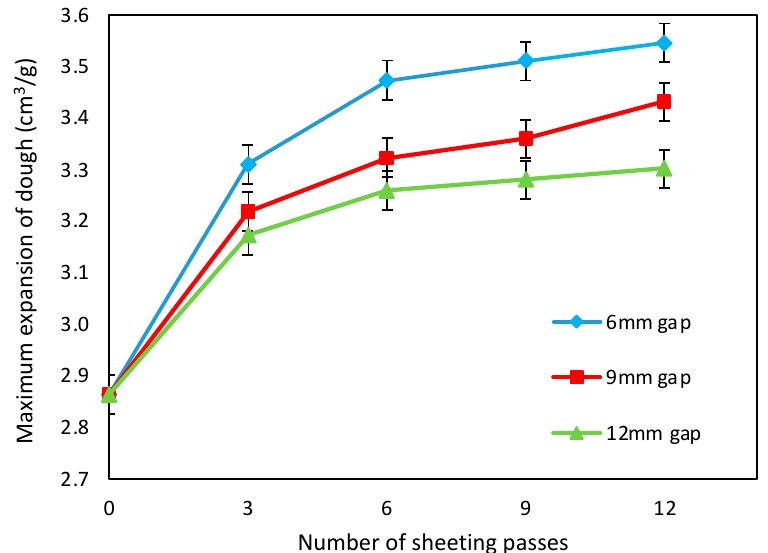
Figure 2. Maximum expansion against number of sheeting passes at a roll gaps of 6, 9 and 12 mm, following initial dough formation in the MajorPin mixer.